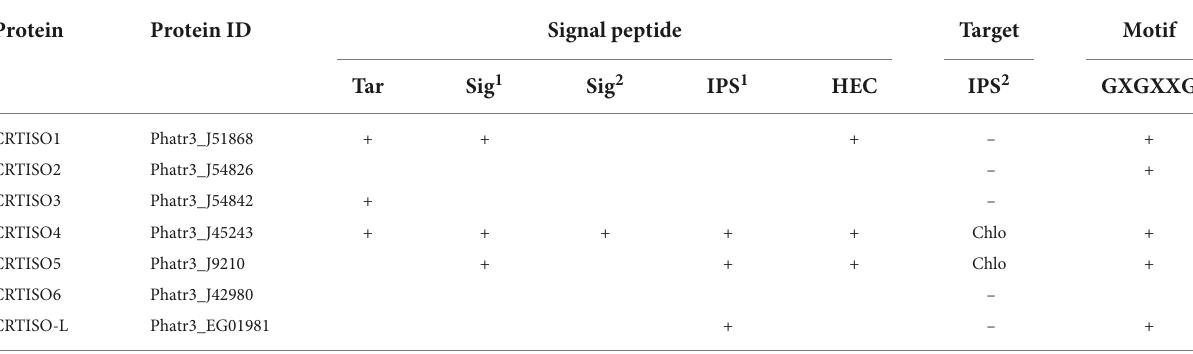
TABLE 2 Sequence analysis of PtCRTISOs candidates.